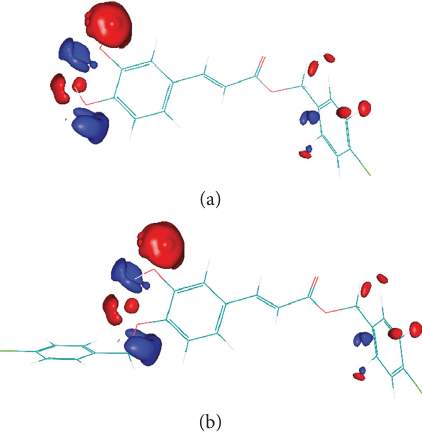
Figure 3: Electrostatic molecular interaction field for compounds 11 and 13 in Staphylococcus aureus